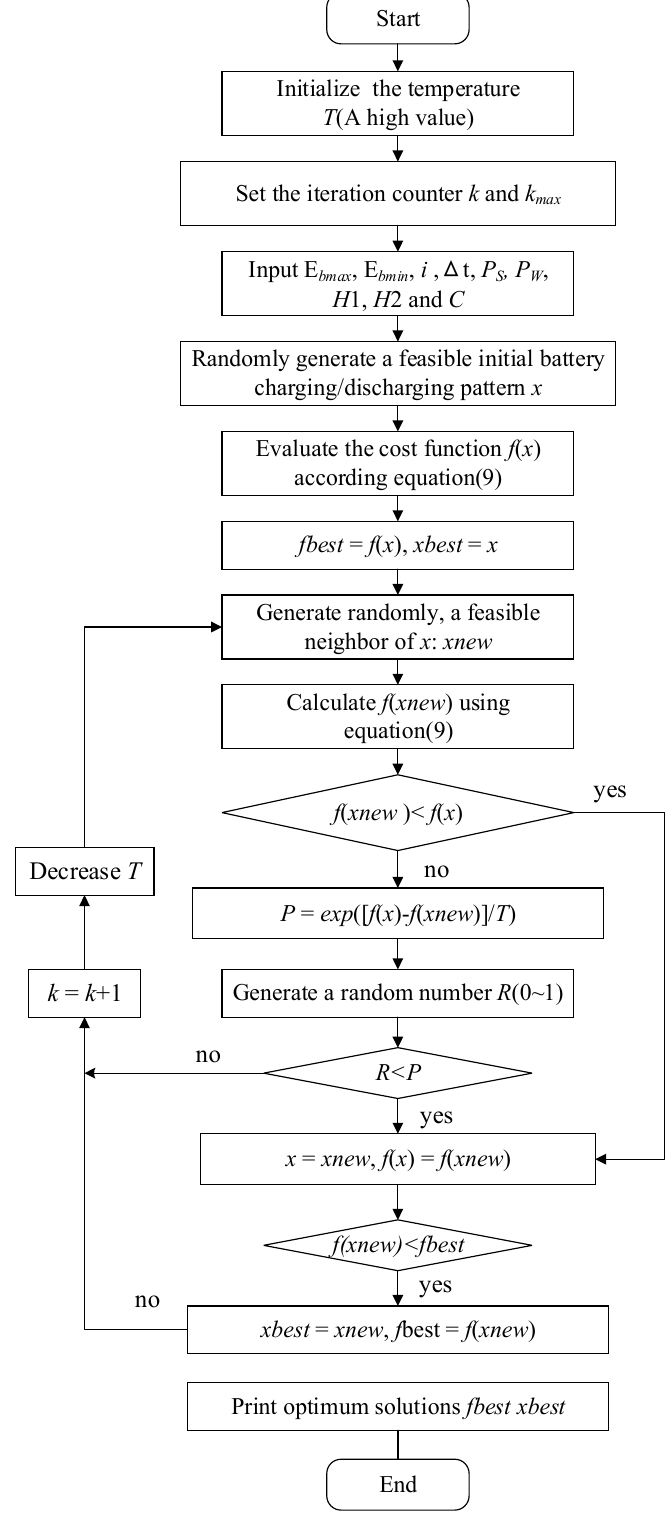
Figure 4. The flow chart for battery scheduling based on an SA algorithm.